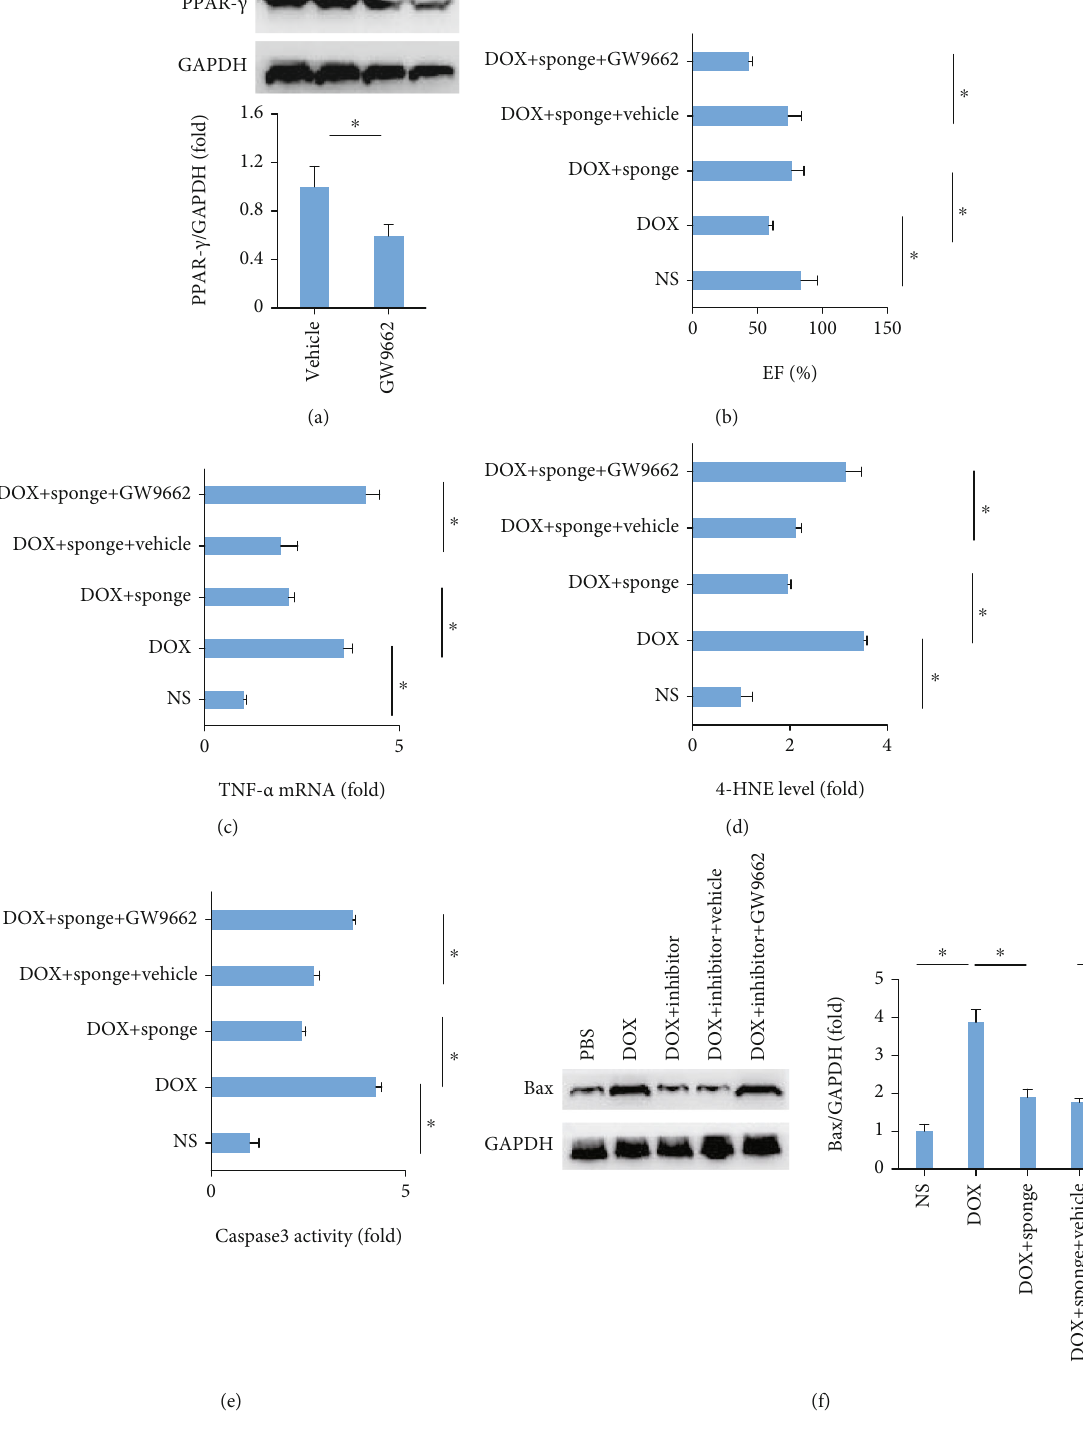
Figure 7: GW9662 abolished protective e ff ects in mice provided by miR-128-3p inhibition. (a) The protein expression of PPAR- γ ( n = 6 ). (b) Ejection fraction ( n = 12 ). (c) TNF- α mRNA level ( n = 6 ). (d) 4-HNE level ( n = 8 ). (e) Caspase3 activity ( n = 8 ). (f) Western blot of Bax ( n = 6 ). Data are expressed as mean ± SEM . ∗ P < 0 : 05 vs. matched